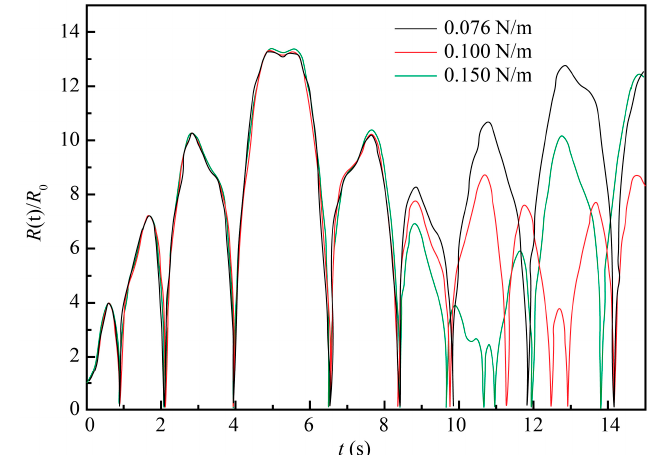
Figure 6. Evolution of cavitation bubble oscillation amplitude for three different values of the viscosity coefficient and constant surface tension coefficient of the electrolyte ( σ ) = 0.076 N/m.